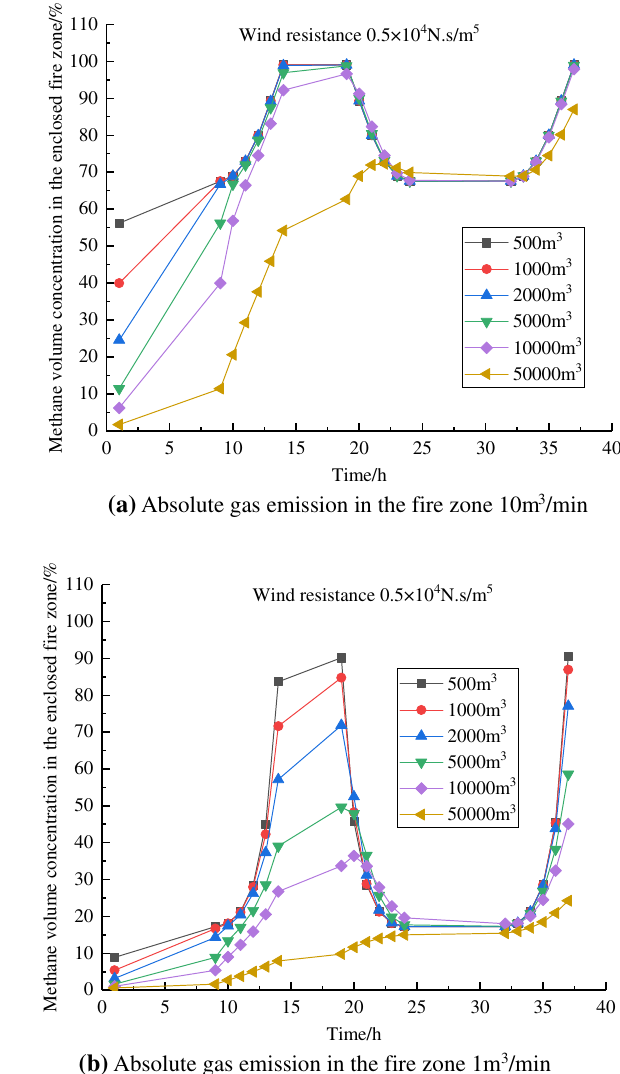
case of damage caused by poor quality of airtight wall or other reasons, the leakage of fresh air may cause to reach the upper limit of explosion. Figure 12 showed the variation of gas concentration inside the fire zone for a period of time after the fire zone is